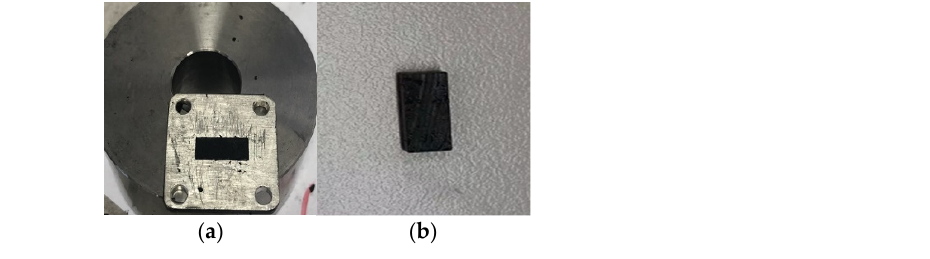
Figure 7. The transmission/reflection coefficient measurement system. Where the red arrow points is where the sample is placed. The instrument circled in red is a vector network analyzer (VNA). The blue arrow shows the coaxial line.